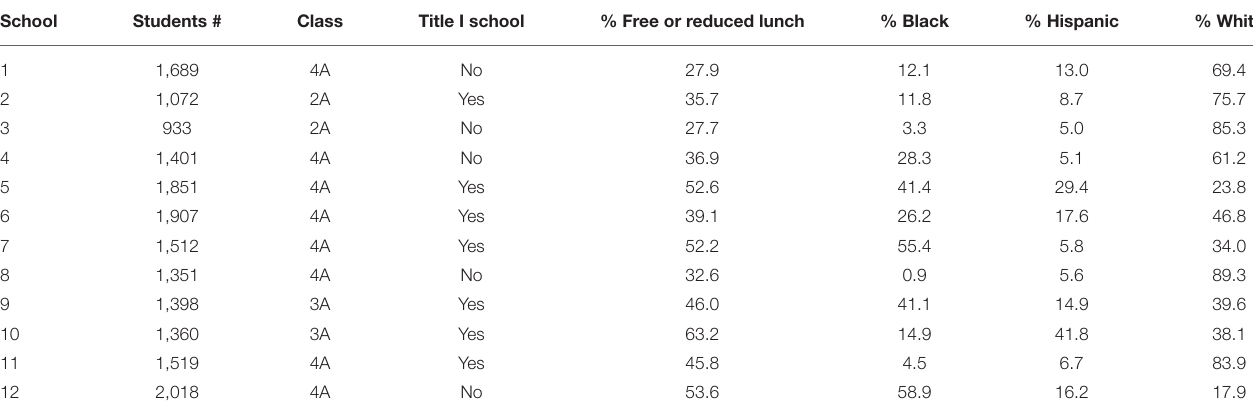
TABLE 1 | Characteristics of North Carolina High Schools and Students in the